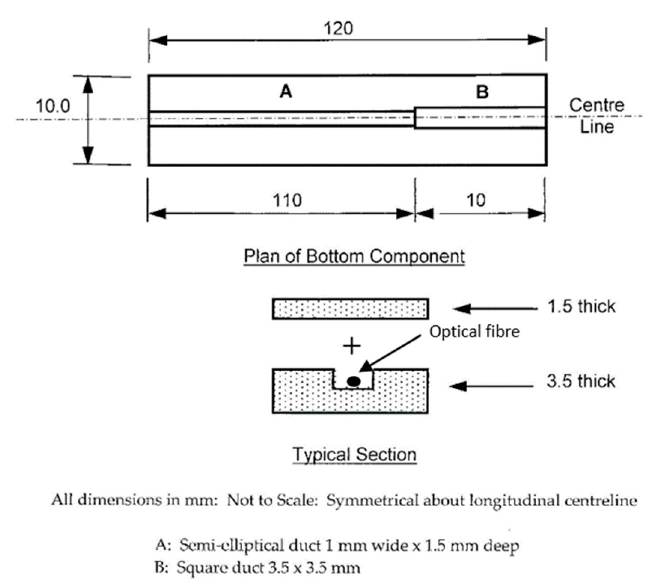
Figure 11. Layout of closed package.